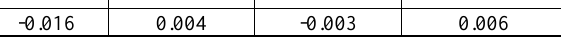
Table 1: Deviations between the actual measurement (1 cm 2 ) and the measurement value